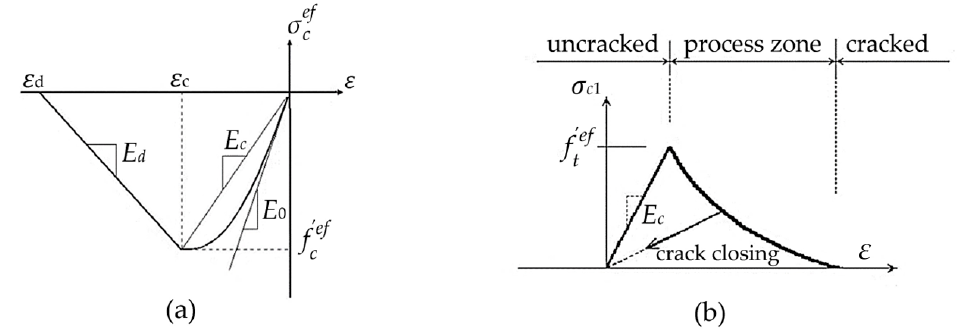
Figure 2. ( a ) Compressive stress–strain diagram; ( b ) stages of crack opening [18].